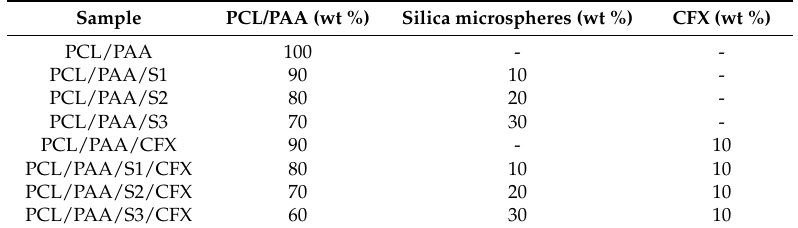
Table 1. Formulation template of silica microspheres and ciprofloxacin-loaded scaffolds. PCL: poly(caprolactone); PAA: poly(acrylic acid); CFX: